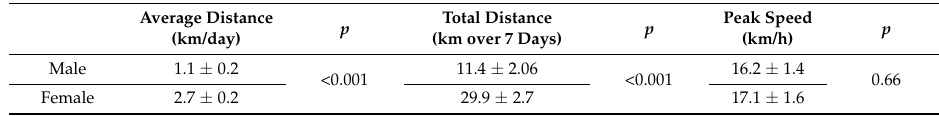
Table 5. Exercise data for males and